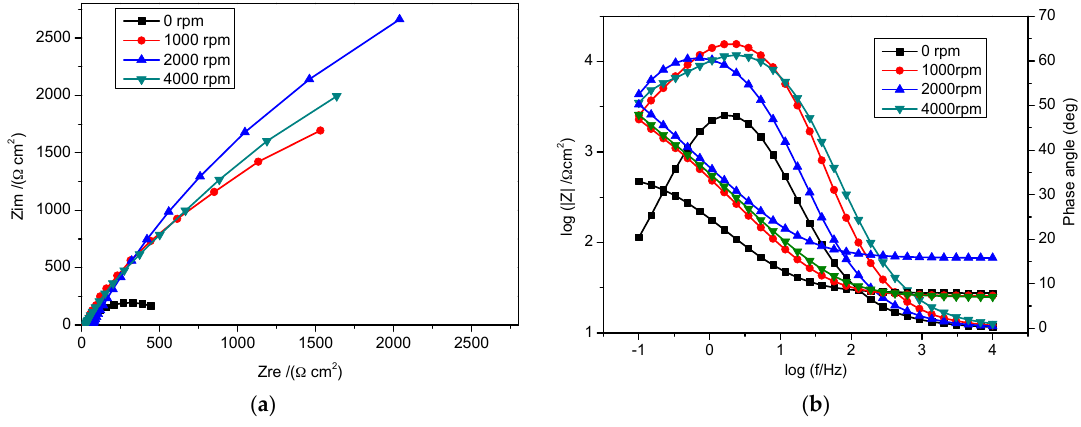
Figure 7. Impedance spectra for mild steel in bicarbonate chloride solution under stagnant and indicated rotating speeds in the presence of 2 g/L NO 2 − + 2 g/L KI at room temperature: ( a ) Nyquist plots and ( b ) Bode and impedance magnitude vs. frequency plots. Table 4. Impedance parameters for mild steel in bicarbonate/chloride solution under stagnant